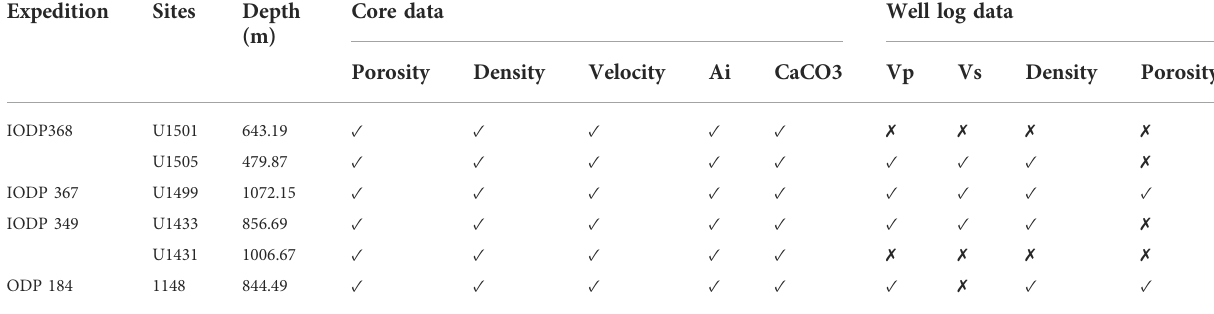
TABLE 1 Summary of rock physics data used in this study from ODP/IODP Sites in the South China sea. Expedition